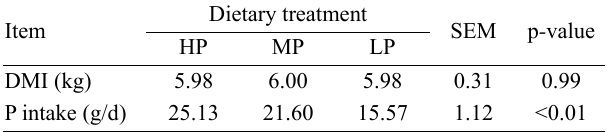
Table 2. DMI and P intake of 8- to10-month-old Holstein heifers